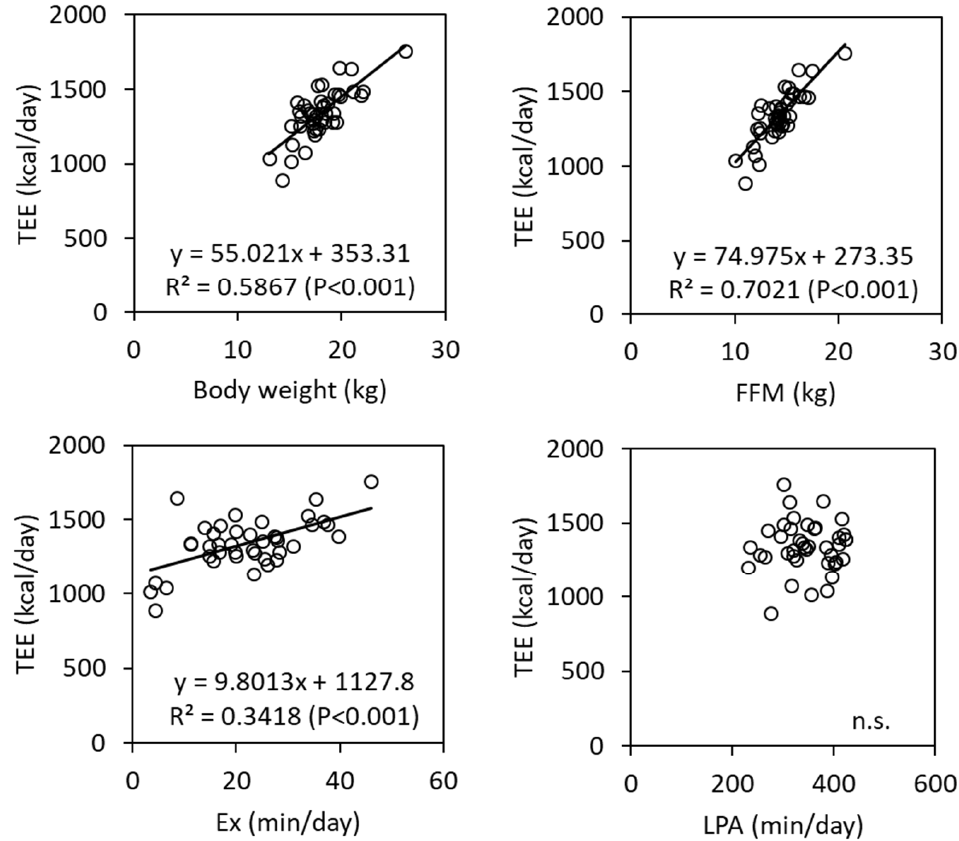
Figure 1. Scatter plots between total energy expenditure (TEE) and body weight, fat free mass (FFM), exercise duration (Ex), and light-intensity activity (LPA).